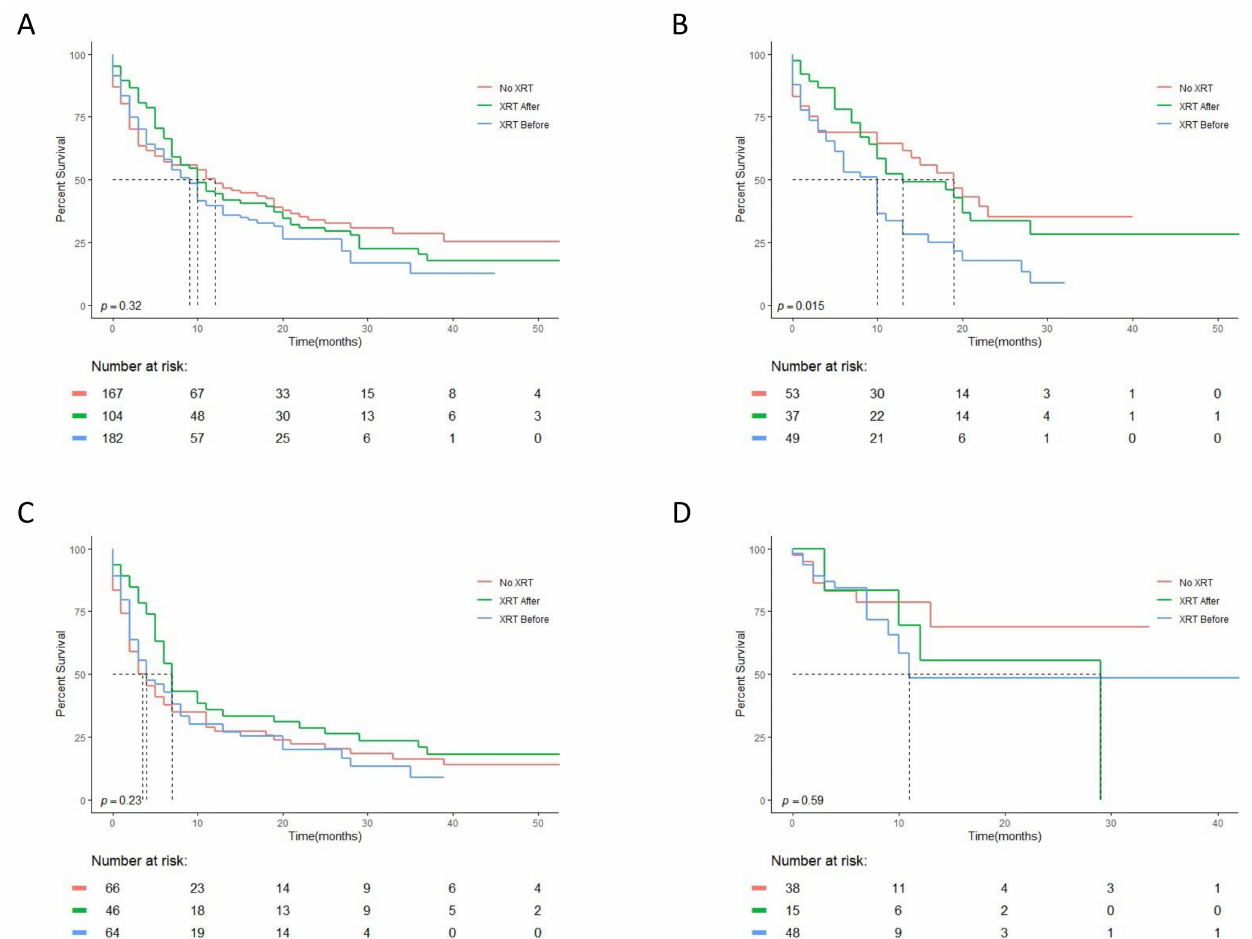
Figure 1. Impact of XRT and its timing relative to IO initiation. Overall survival of the different timing groups (no XRT, XRT after IO, XRT before IO) in ( A ) all of the study patients, ( B ) patients treated with pembrolizumab as a single agent, ( C ) patients treated with nivolumab as a single agent and ( D ) patients given chemotherapy and IO combination